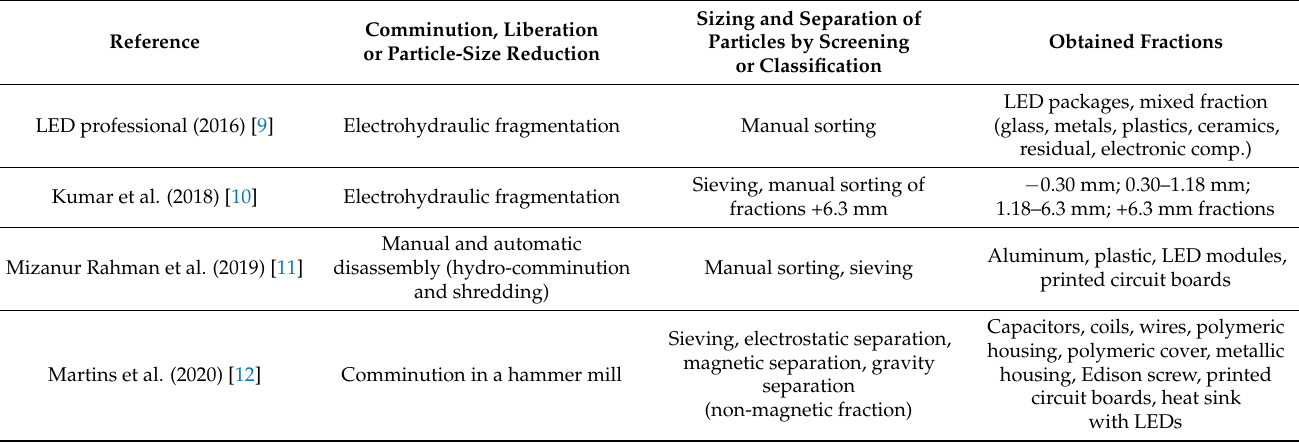
Table 1. Studies on liberation and concentration of valuable components from LED